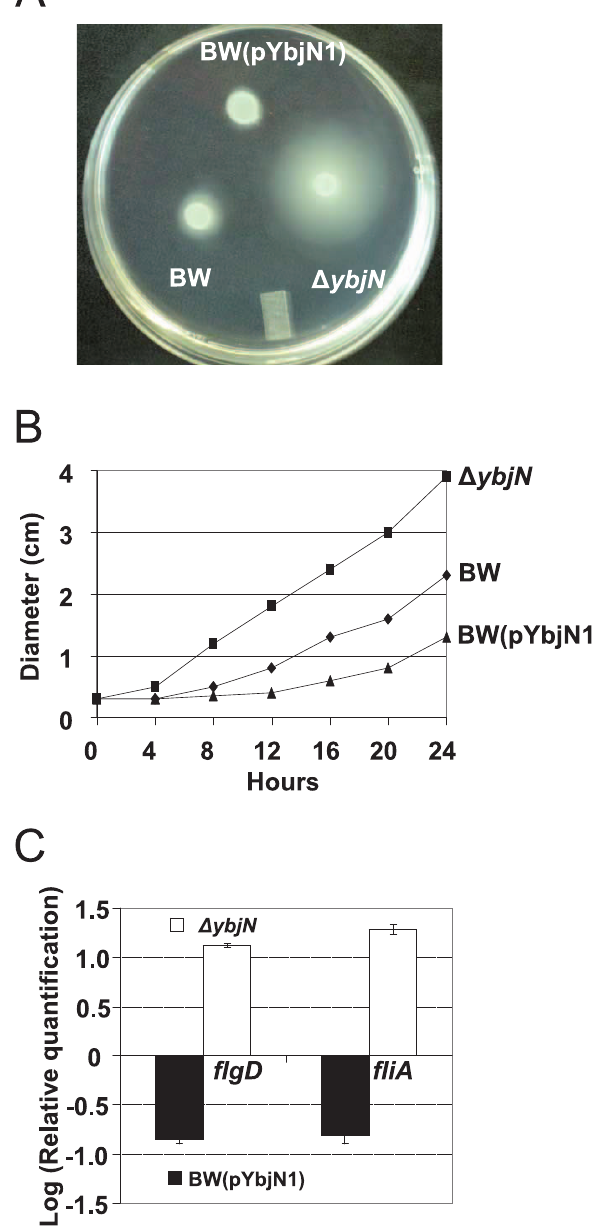
Figure 4. YbjN suppresses bacterial motility and over-expression of ybjN negatively regulates flagellar gene expression. A. Migration phenotypes of E. coli strain BW25113 (BW), ybjN mutant and BW over-expressing ybjN at12 h after incubation. B. Comparison of the movement distance of BW, ybjN and BW over-expressing ybjN . Cells were inoculated on the surface of a motility plate containing 0.25% agar as described previously [20]. Plates were incubated at 30 u C for 24 h, during which the displacement (diameter) of the outermost edge of the movement was measured. The experiment was performed for three times in triplicate. Errors bars were smaller than the symbols. C. Relative expression of fliA and flgD gene expression in ybjN mutant and BW over-expressing ybjN compared to BW strain. Bacterial strains were grown overnight in LB broth and re-inoculated in 5 mL M9 medium. Relative expression of fliA and flgD genes, normalized to the expression value of 16S rRNA ( rrsA ) gene, was determined by qRT-PCR after 8 h growth (OD 600 at 0.5–0.8) in M9 medium.